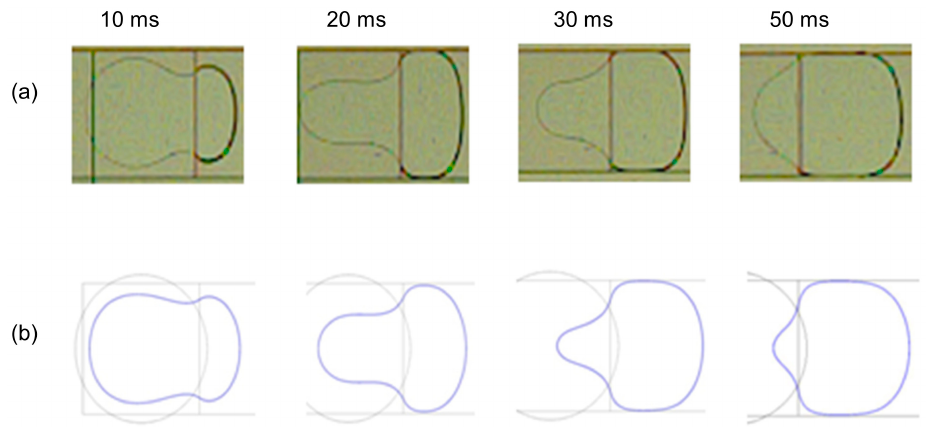
Figure A2. Droplet interfaces on square electrodes at different time intervals. ( a ) Images from the experiment; ( b ) Droplet free surface profiles from simulation (in blue).